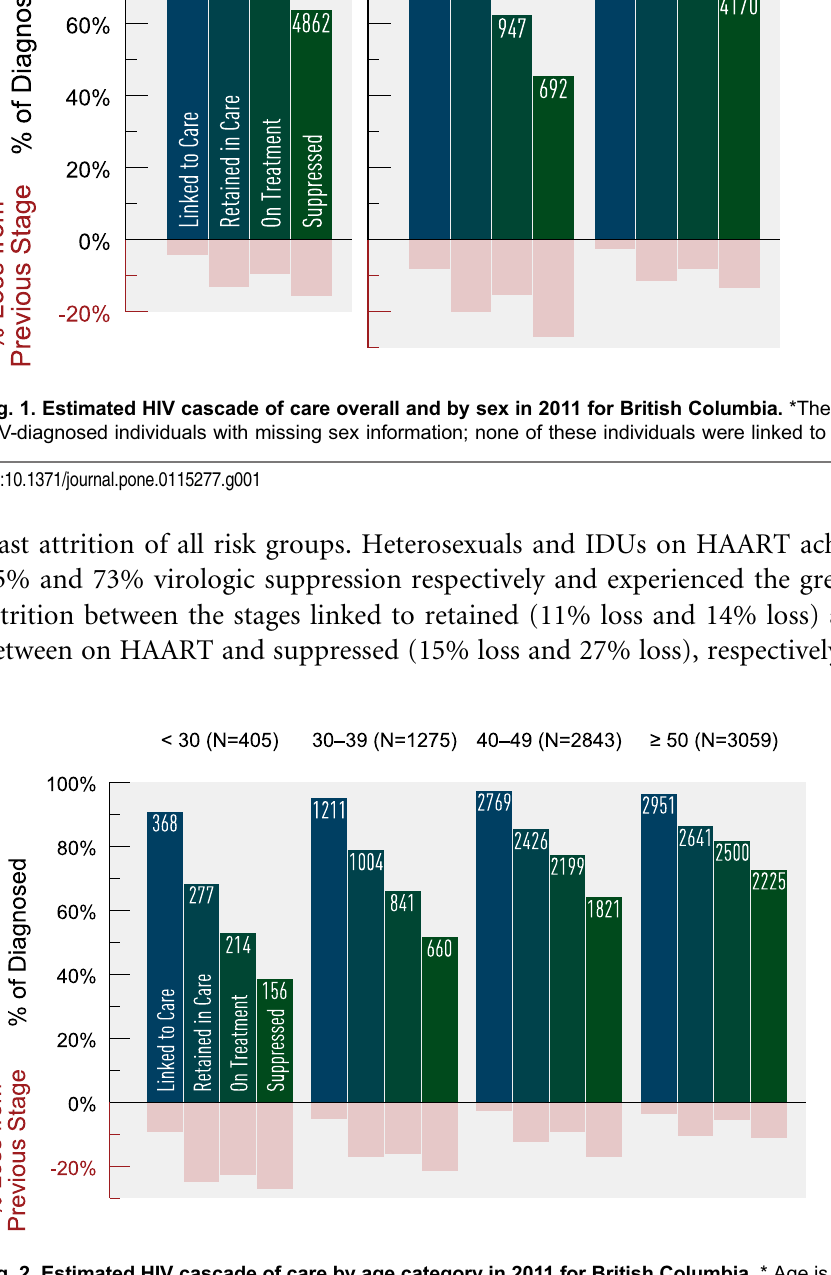
Fig. 2. Estimated HIV cascade of care by age category in 2011 for British Columbia. * Age is defined as age as of January 1 st , 2011. There were 39 HIV-diagnosed individuals with missing age information; none of these individuals were linked to HIV